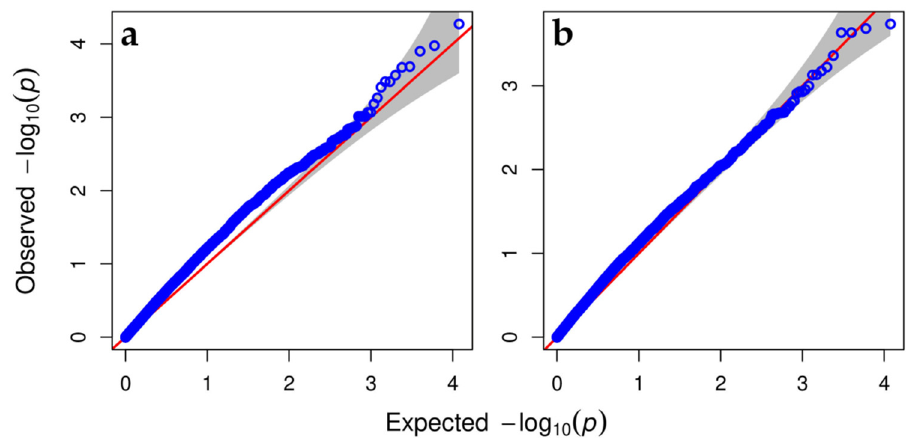
Figure 2. Quantile–quantile (QQ) plot showing how well the models ( a ) GLM and ( b ) MLM, used in GWAS, account for population structure and familial relatedness in a pooled sample of 139 progenies (populations 2-11, 3-11, 4-11) from three crosses. Here, an association of SNPs with the trait ‘intensity of phylloxera gall formation’ (R, %) was analyzed.